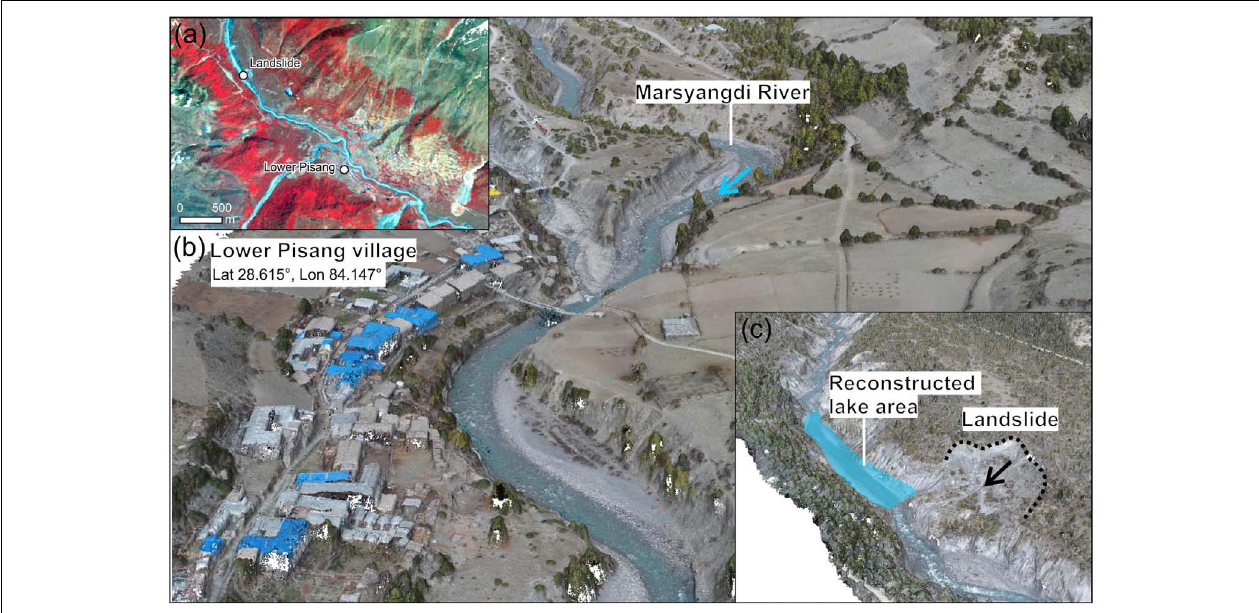
FIGURE 3 | (a) Location of a landslide-dammed lake upstream of Lower Pisang village from a 11 May 2015 RapidEye composite of bands NIR, red, and blue (Planet Team, 2018). (b) Shows a point cloud of the Marsyangdi River (April 2018) from Watson et al. (2019), derived from UAV imagery processed following a structure from motion with multi-view stereo workflow. (c) Shows the landslide dammed lake that formed following the Gorkha earthquake and was monitored by Kargel et al. (2016).